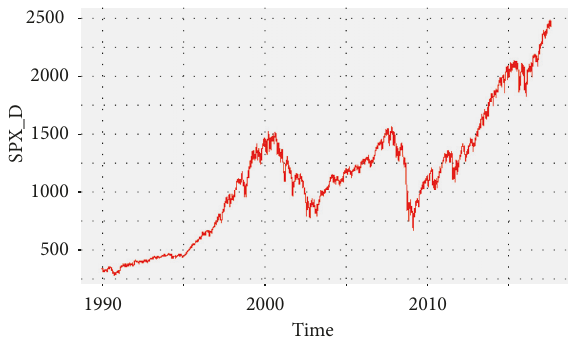
Figure 1: Variation of SPX price with